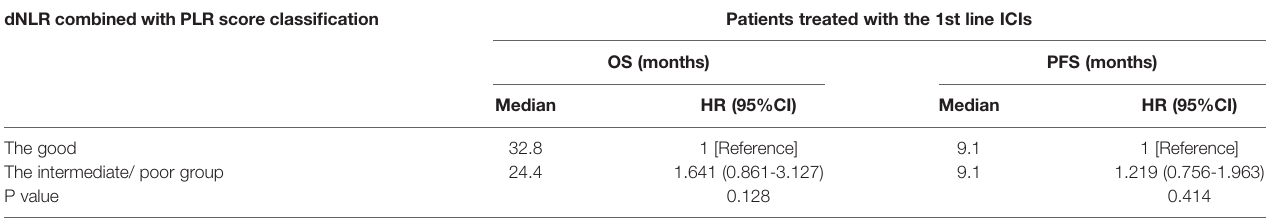
TABLE 8 | Univariate analyses of the good group and the intermediate/poor group associated with OS and PFS of AGC patients treated with 1 st line ICIs. dNLR combined with PLR score classi fi cation Patients treated with the 1st line